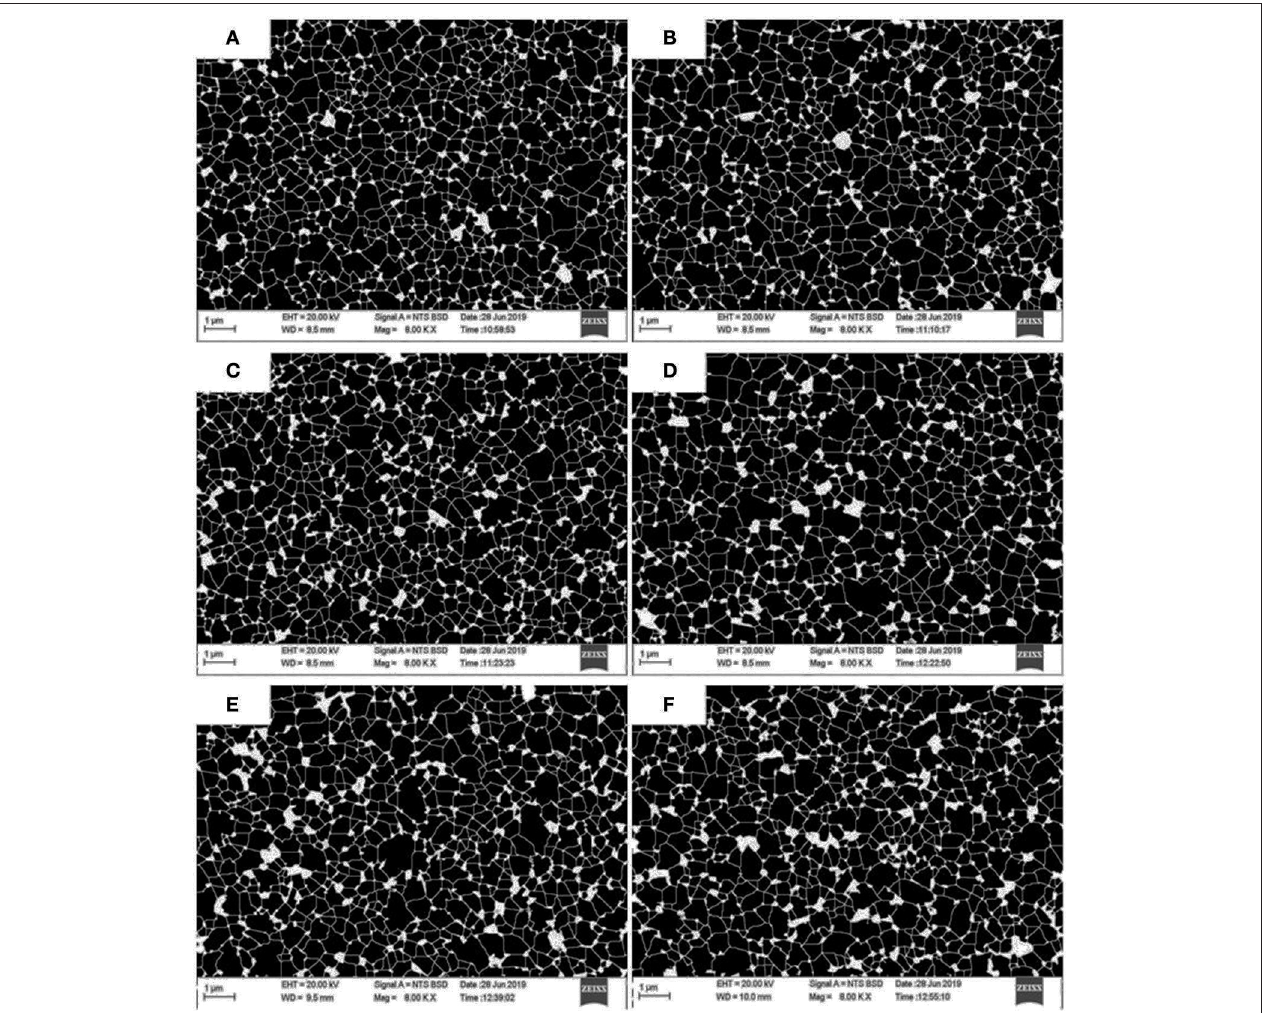
FIGURE 3 | Binary images of the alloys with different Mo 2 C addition amount: (A) 0% Mo 2 C; (B) 1.2% Mo 2 C; (C) 2.4% Mo 2 C; (D) 3.6% Mo 2 C; (E) 4.8% Mo 2 C; (F) 6.0% Mo 2 C.